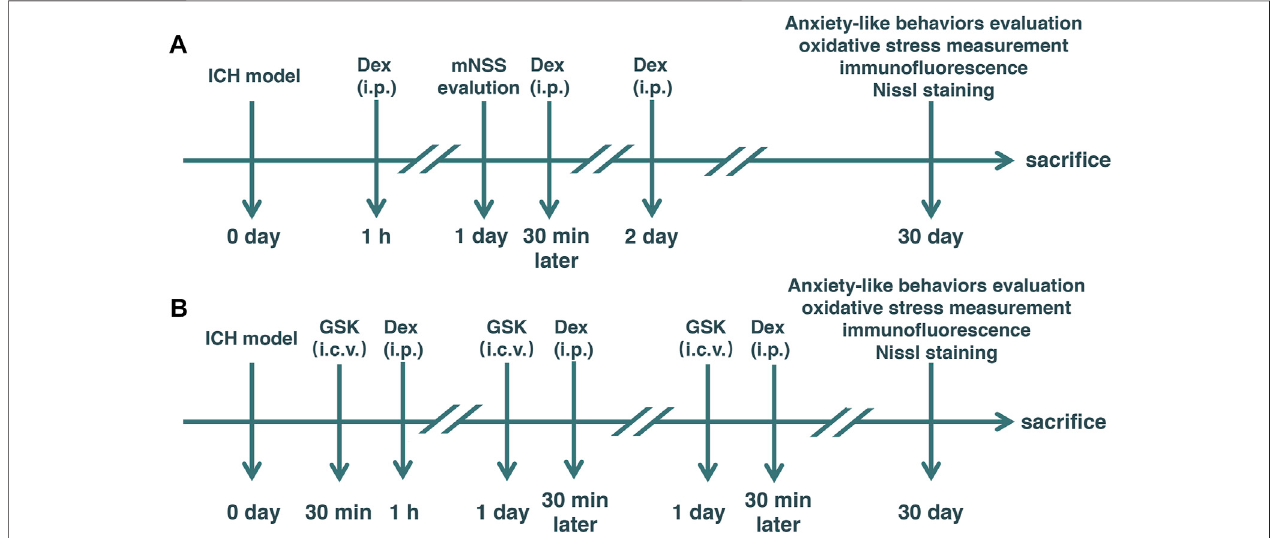
FIGURE1| Experimentalschematicdiagram.Micewithintracerebralhemorrhage(ICH)anddexmedetomidine(Dex)administration.Elevatedplus-mazeandopen- fi eld tests were used to evaluate anxiety-like behaviors. ICH: Rats received an injection of autologous arterial blood (20 μ l) in the basal ganglia. mNSS: modi fi ed neurological severity score (A) Dex: 25 μ g/kg Dex using intraperitoneal injection was administered post-ICH daily for 3 days. (B) GSK: GSK1016790A, an agonist of transient receptor potential vanilloid 4 (TRPV4), injected into the left lateral ventricle 30 min before Dex administration. Sham: Mice underwent identical surgery except for ICH